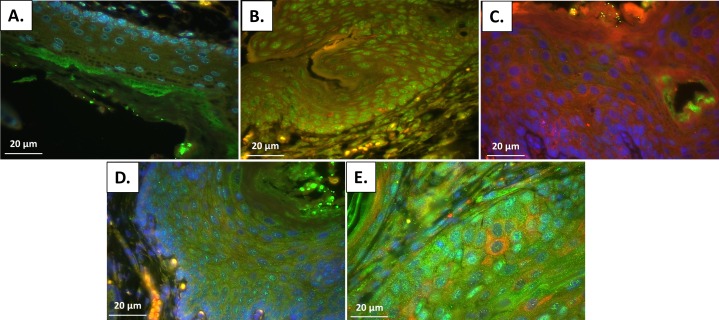
Immunofluorescence for autophagic proteins following DMBA treatment.Immunofluorescence for LC3β (cytoplasmic, green), p62 (cytoplasmic, red) and DAPI (nuclear, blue) at various time points of treatment. (A) At 0 weeks of treatment, there is a low level of punctate LC3β expression and minimal p62 noted, indicating low levels of autophagy in this untreated specimen. (B) After 5 weeks of DMBA treatment, there is evidence of autophagic induction with the increase in punctate, granular LC3β compared to 0 week treatment mice (A). (C) An overlay image with co-expression (LC3β and p62) expressed as orange at the 5 week time point compared to LC3β alone in panel B indicates a mild increase in p62 in addition to LC3β at this time point. (D) With 10 weeks of DMBA treatment, there is significant accumulation of p62 expression and an increase in punctate LC3β indicating autophagic induction without degradation of autophagy-specific substrate p62. (E) At 15 weeks of DMBA treatment, the time of development of high-grade dysplasia, p62 levels begin to decrease with continued evidence of punctate LC3β indicating autophagic induction with the ability to degrade p62. (F) At 20 weeks of treatment, where carcinoma is present, there is again a significant increase in LC3β punctate expression with low levels of p62. All images are acquired at 20x magnification.